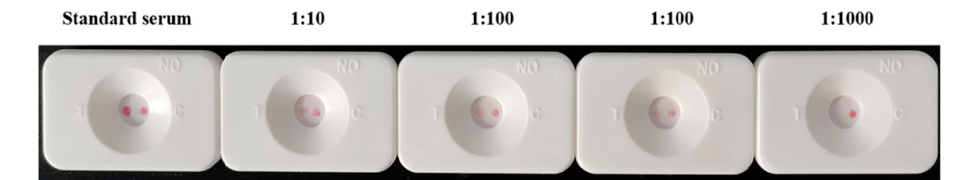
Figure 13. Experimental results of RVFT detection limit.